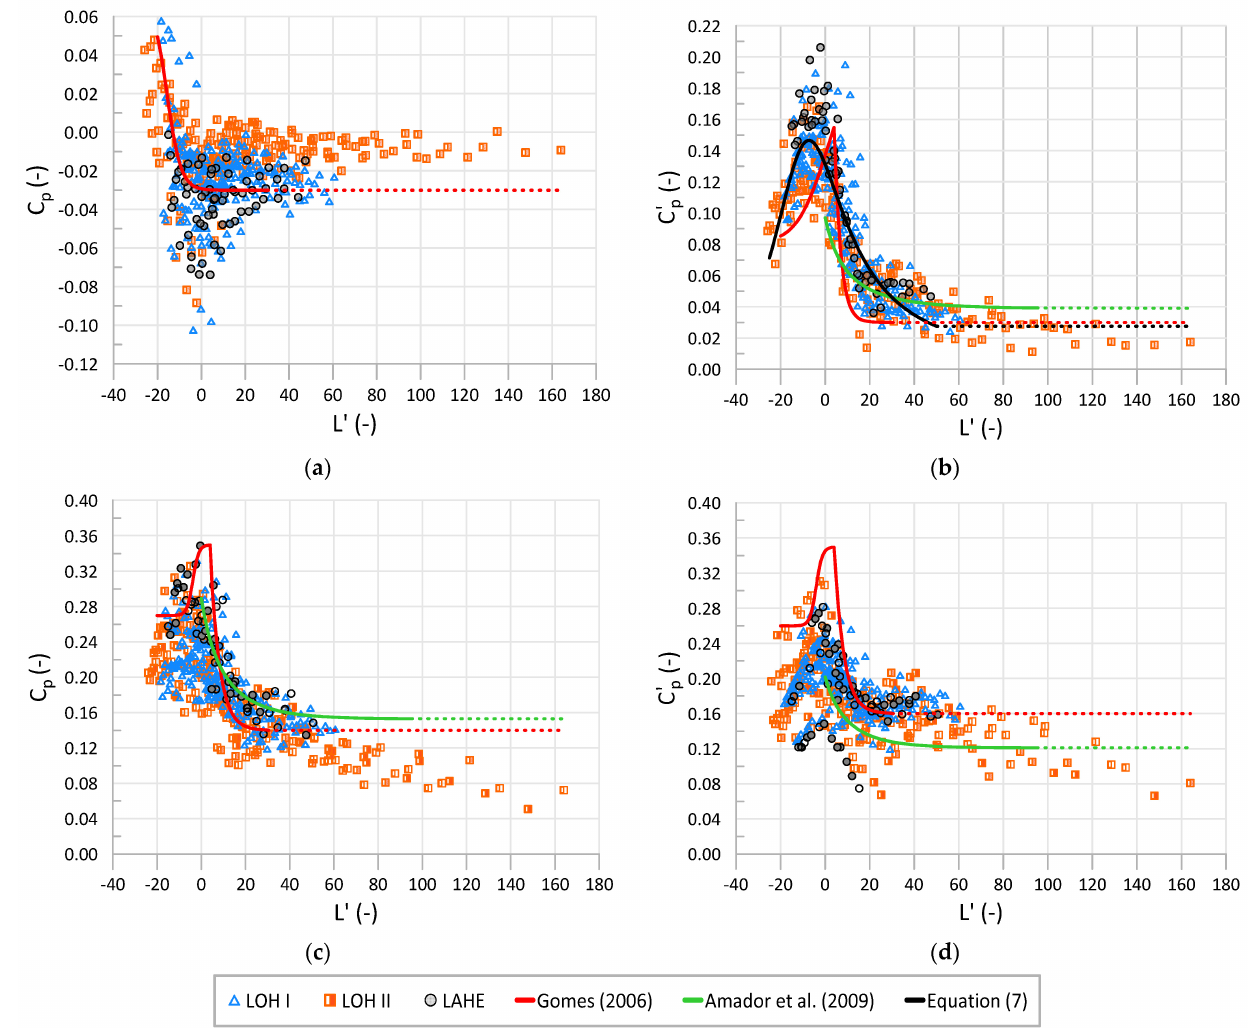
Figure 8. Streamwise development of the mean ( left ) and fluctuating ( right ) pressure coefficients, at the LOH I, LOH II, and LAHE stepped chutes: ( a , b ) vertical face of the step, near the outer edge; ( c , d ) horizontal face of the step, near the outer